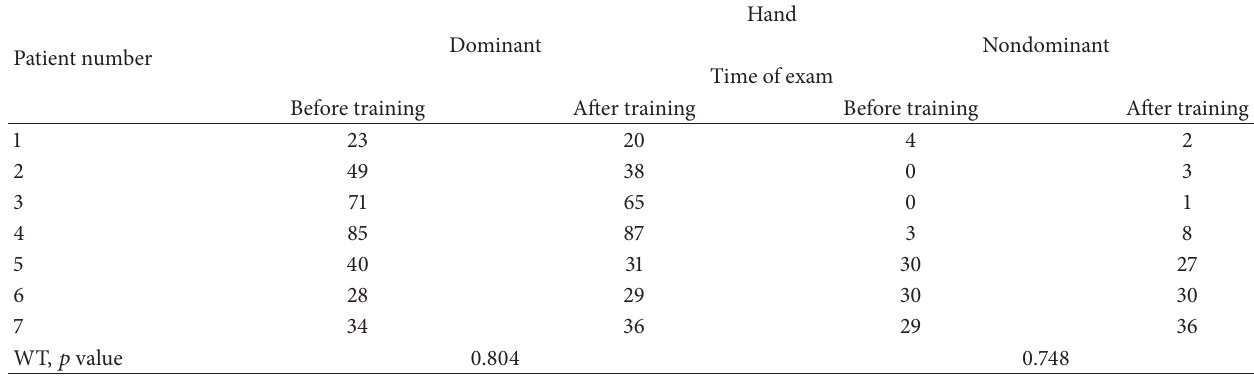
Table 4: Results of the Box and Block test. Number of moved wooden cubes before and after training and p values in Wilcoxon signed-rank test (WT) are given.